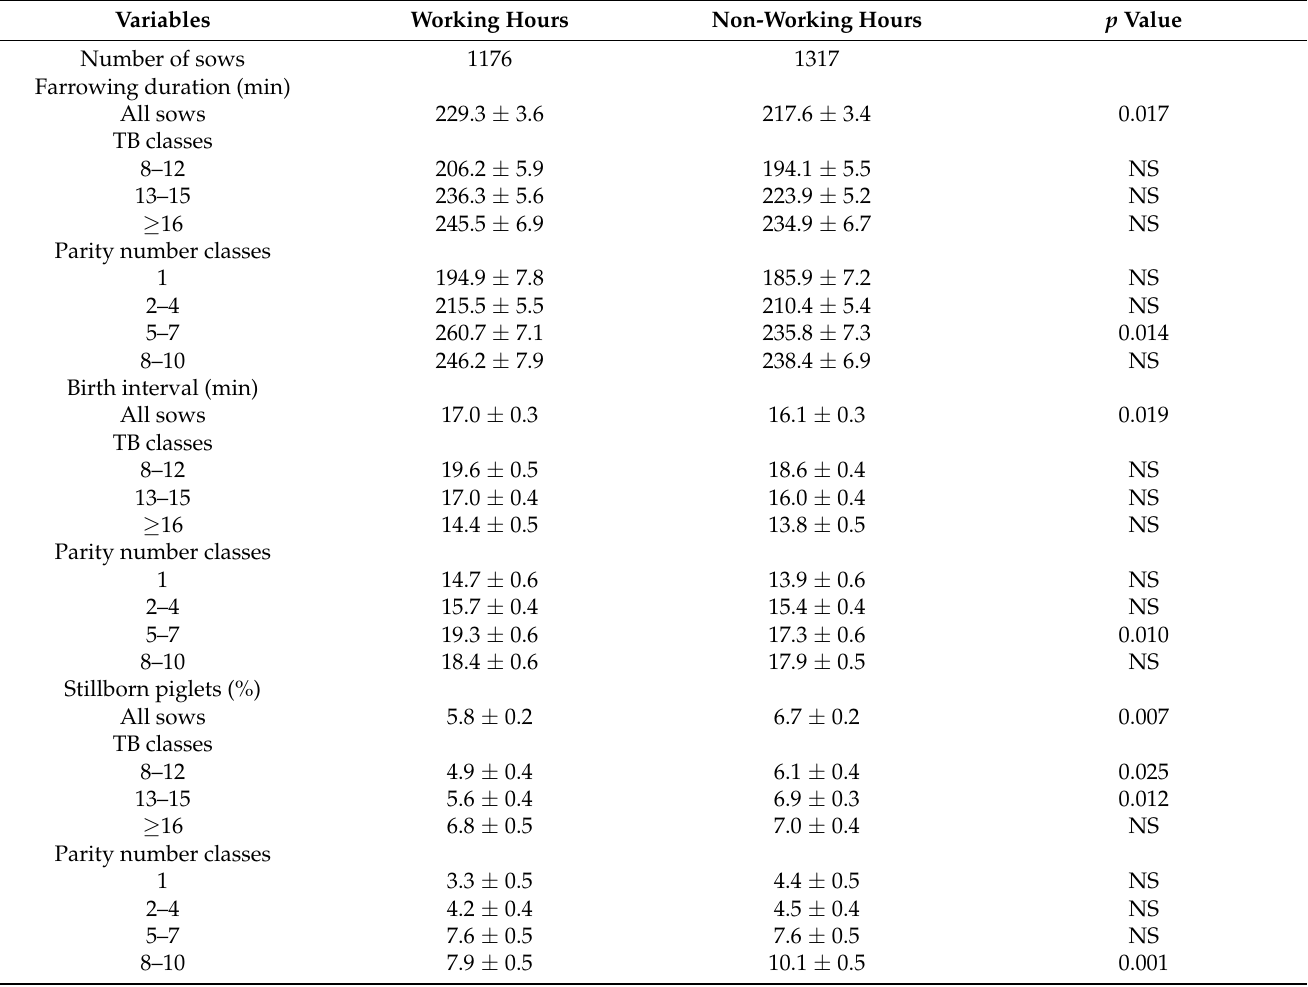
Table 5. Farrowing duration, birth intervals and percentage of stillborn piglets during working hours